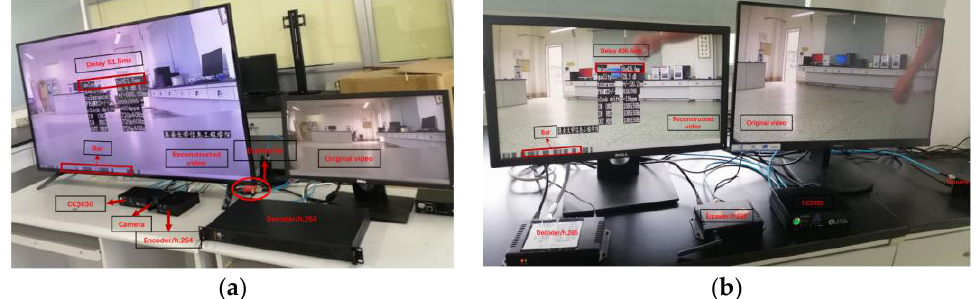
Figure 9. ( a ) Delay measurement of H.264 codec; ( b ) Delay measurement of H.265 codec. The Chinese characters in the two pictures are “School of Information Engineering, Jimei University”.